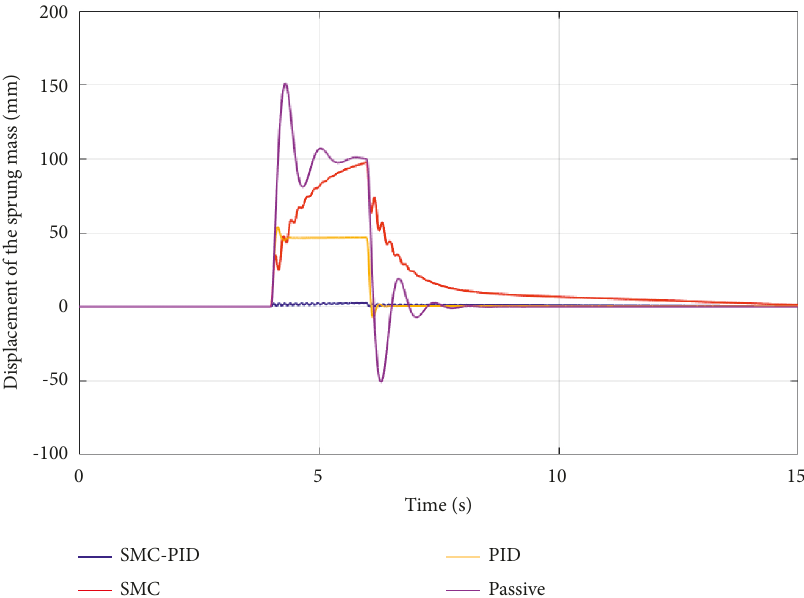
Figure 12: Displacement of the sprung mass (Case 3).